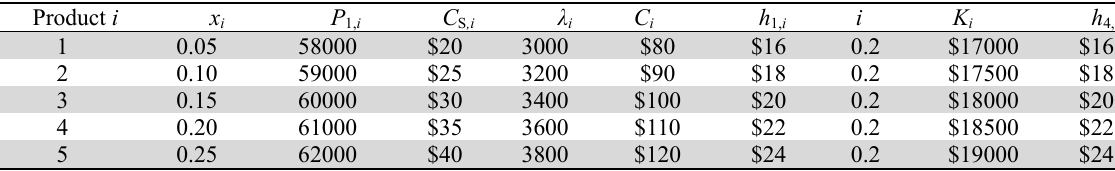
Assumed parameters for a single-stage fabrication problem